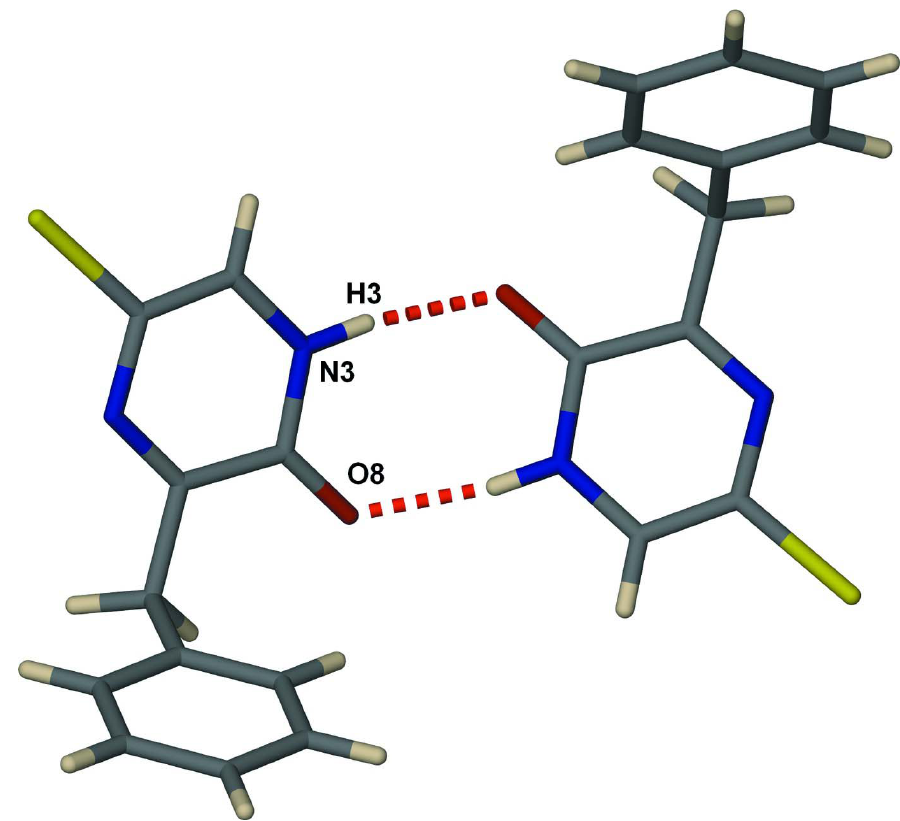
Figure 2 Hydrogen-bonded dimer. Hydrogen bonds are shown as dashed lines. The unlabeled molecule is related to the labeled one by the symmetry operation 3/2 - x , 3/2 - y , z